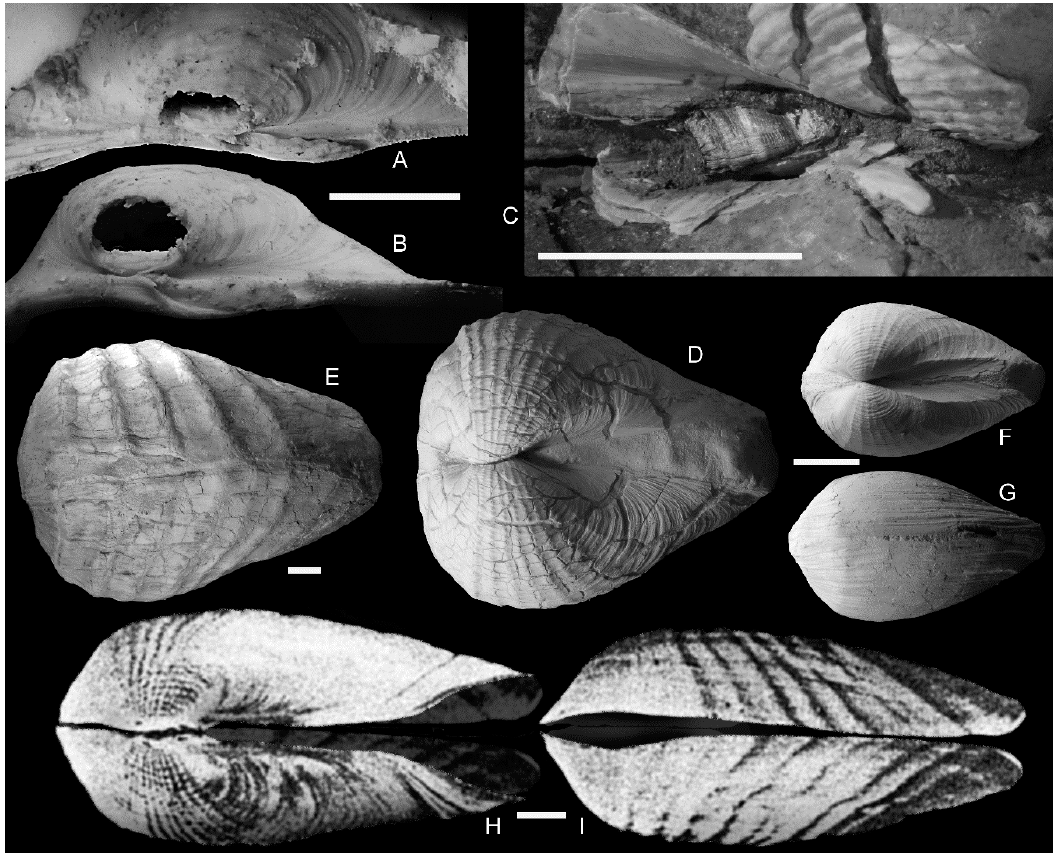
Figure 1. Hinges of Pholadomya . ( A , B ), A silicone cast of the right hinge of Pholadomya protei (Dziwnówek, specimen MGUS.Sz.3464) in dorsal and left view. ( C ), A calcified fibrous layer of Ph. lirata (Cz˛estochowa, MGUS.Sz.3916) ligament. ( D – I ), Dorsal and ventral margins of Ph. lirata (Cz˛estochowa, ( D )—MGUS.Sz.3733 and ( E )—MGUS.Sz.3515), Ph. concatenata (( F , G )—MGUS.Sz.3917) and Ph. candida (( H , I )—from Runnegar 1972, Pl. 1, Figure e,f, modified) shells. Scale bar 1 cm (as in other figures, unless otherwise stated).